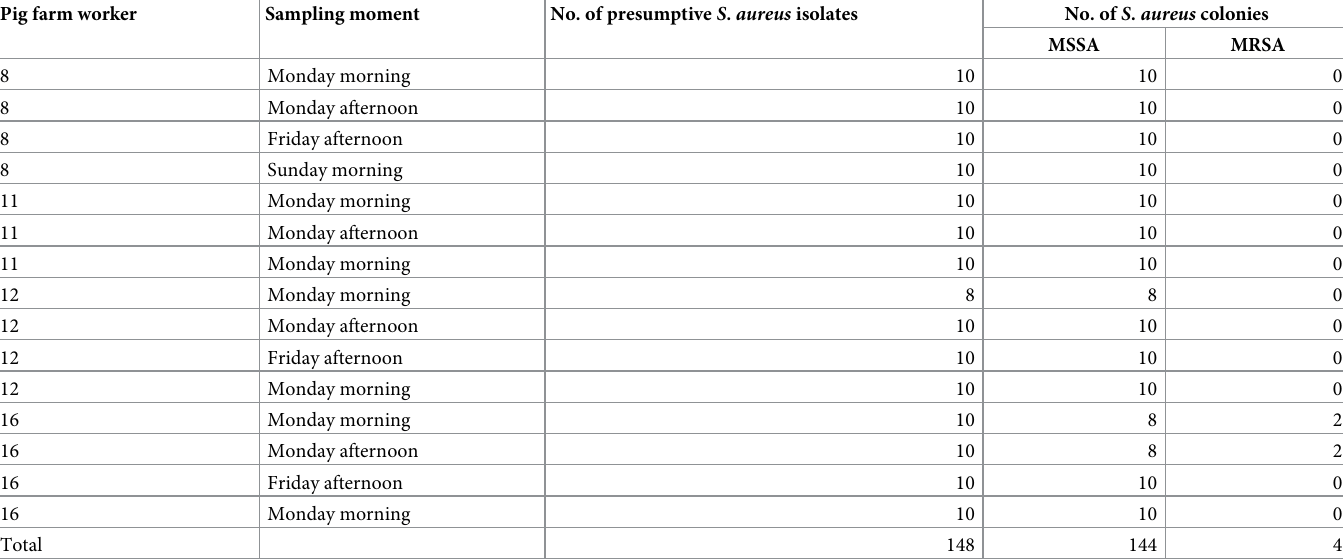
Table 3. PCR analysis of 148 presumptive S . aureus isolates from selected pig farm workers following growth on SaSelect agar. Pig farm worker Sampling moment No. of presumptive S . aureus